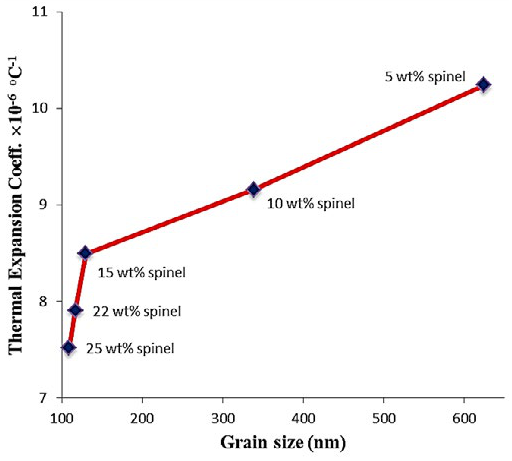
Fig. 6. The grain size dependence of the thermal expansion coefficient for Y-PSZ with different MAS